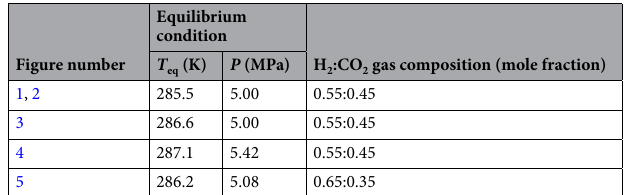
Table 2. Equilibrium conditions and gas compositions in each experimental system.